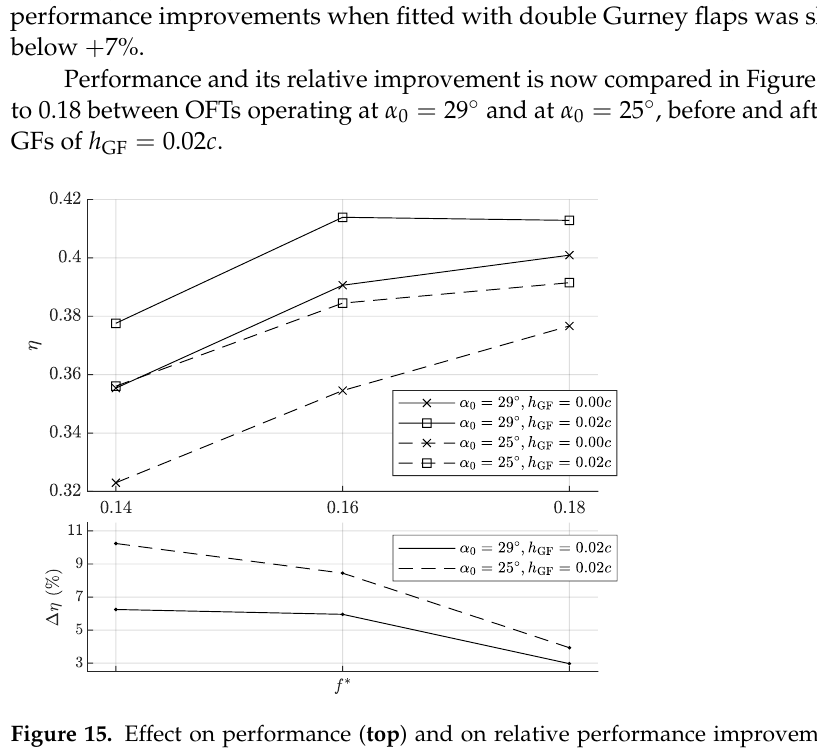
Figure 15. Effect on performance ( top ) and on relative performance improvement ( bottom ) of a h GF = 0.02 c double GF fitted to turbines operating at α 0 = 29 ◦ and α 0 = 25 ◦ . Performance is still improved in all turbines, with relative improvements ranging from ≈ + 3% to more than + 10%. The fact that the same GFs ( h GF = 0.02 c ) on different turbines produce different results is now evidenced. The highest relative performance improvement ( + 10.2%) is obtained for the lowest-performing no-flap case ( f ∗ = 0.14 and α 0 = 25 ◦ ). Further, turbines operating at α 0 = 25 ◦ all produce a lower base performance, but see greater improvements by the addition of double GFs, compared with α 0 = 29 ◦